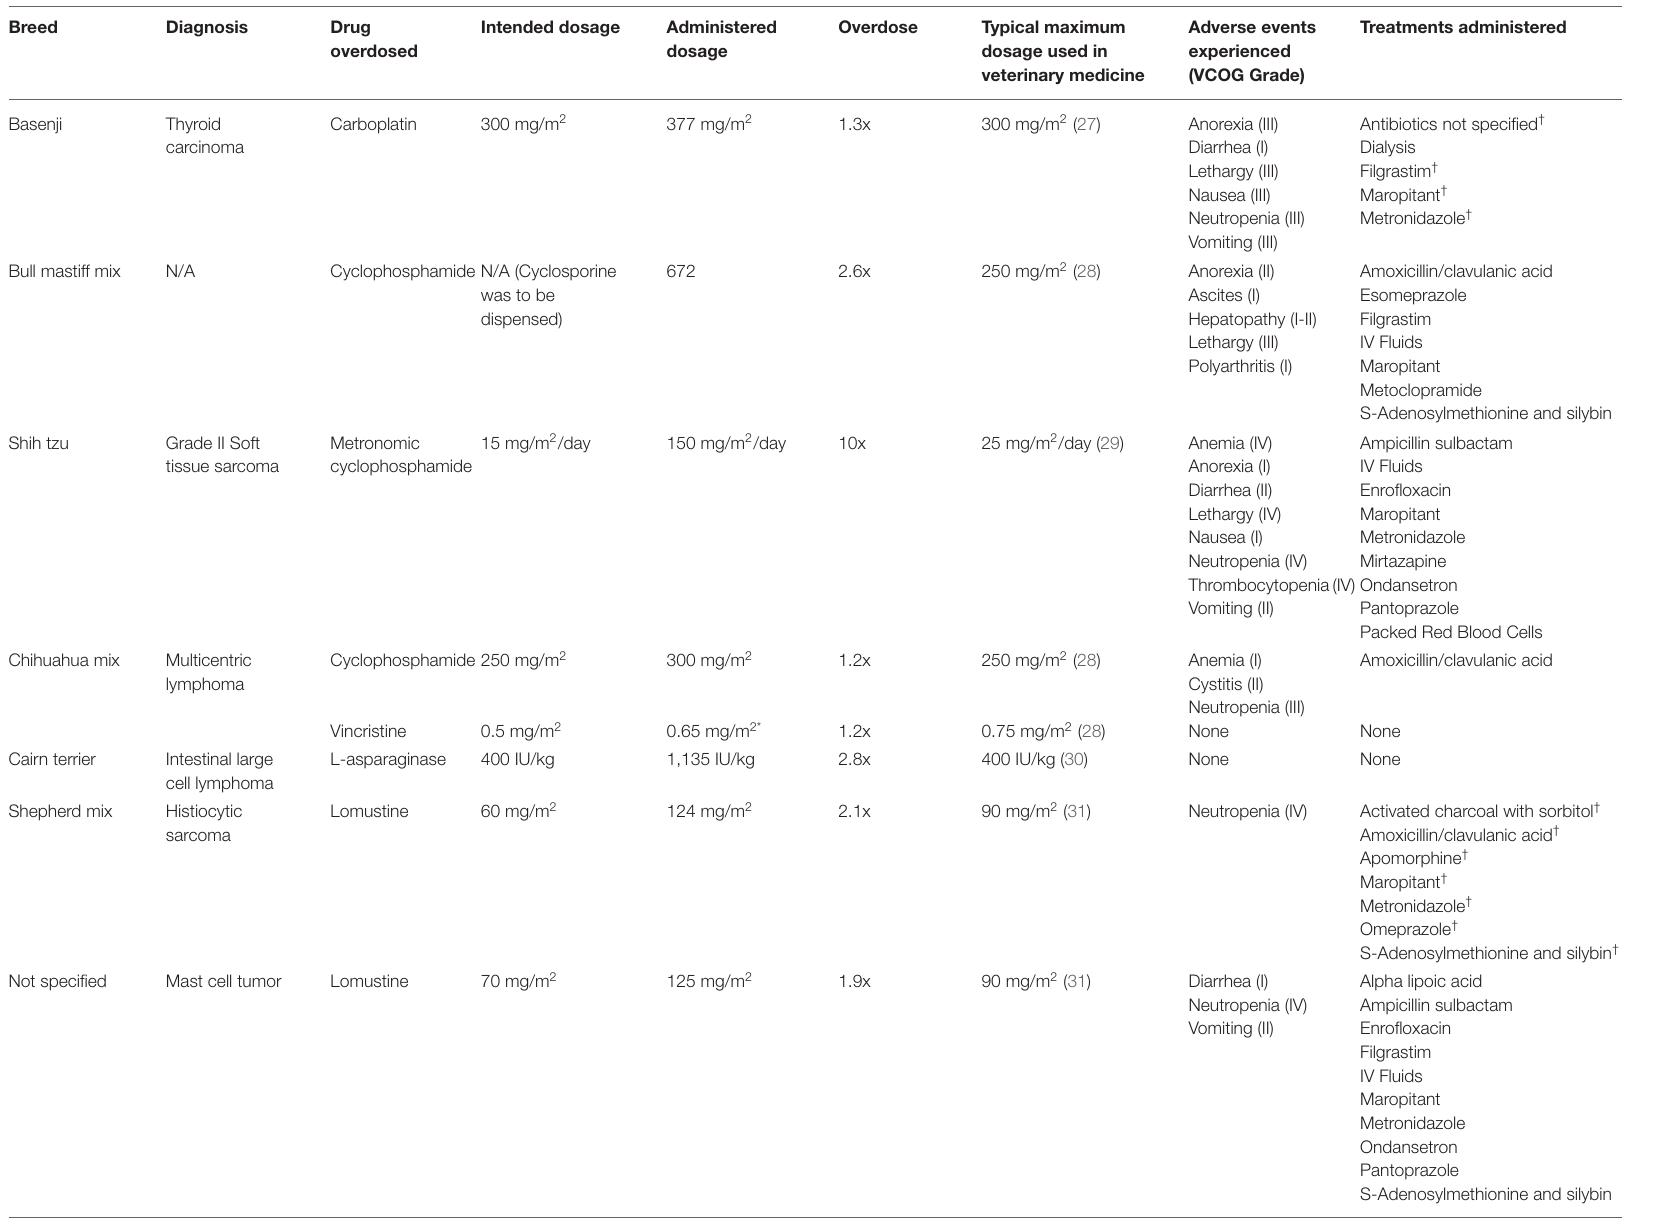
TABLE 1 | Characteristics of dogs and cats experiencing chemotherapy